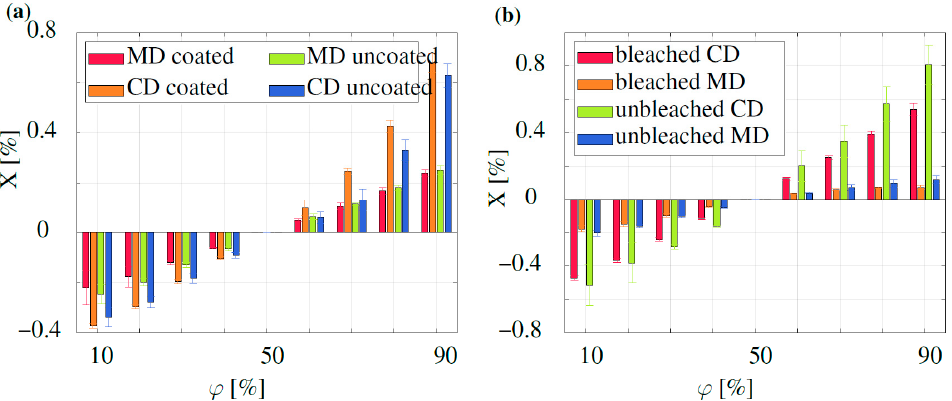
Figure 4. Hygroexpansion of metalized/coated paper compared to raw paper ( a ) and Kraft paper ( b ) in machine direction (MD) and cross direction (CD). ( b ) in machine direction (MD) and cross direction (CD).